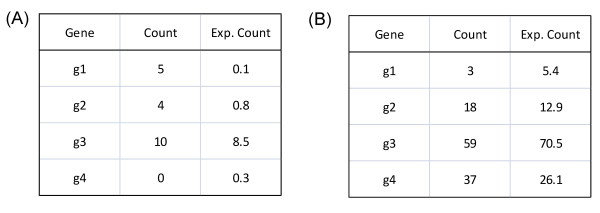
Simple examples for the term significance test. Each table represents the (hypothetic) data for one test term. The second column shows the count of the test term in the document set of a gene, and the third column shows the expected count according to the null distribution (assuming that the term is not related to the gene). The expected count is the product of the frequency of the term in the background collection and the length of the document set of the gene. E.g. in the first row of table (A), 5 means the term appears five times in all the documents associated to g1, and 0.1 is the expected counts according to the background. (A) An example where the term may be related to the first two genes. (B) An example where the term does not appear to be significantly related to any gene.